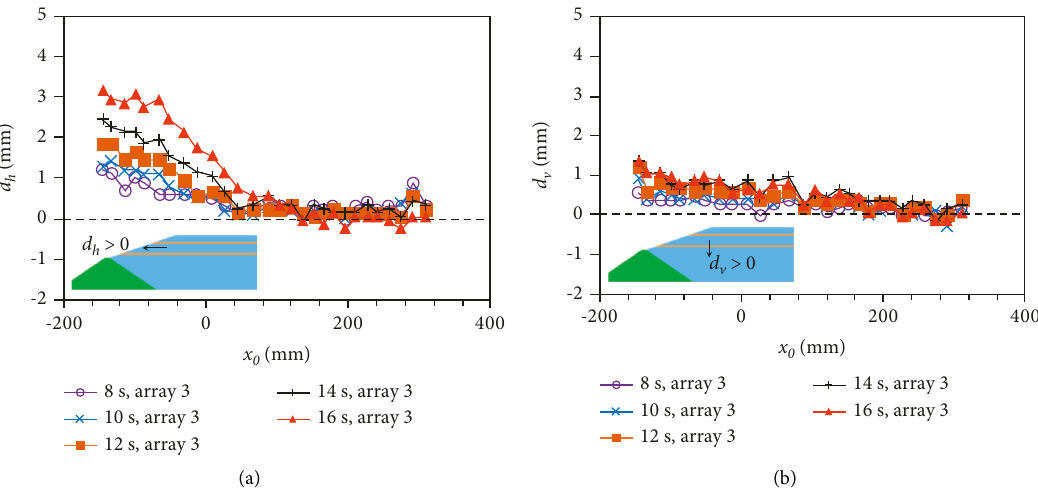
Figure 11: Horizontal distributions of (a) horizontal and (b) vertical displacements of the trace markers in array 3 above the relatively deep silty layer in stage